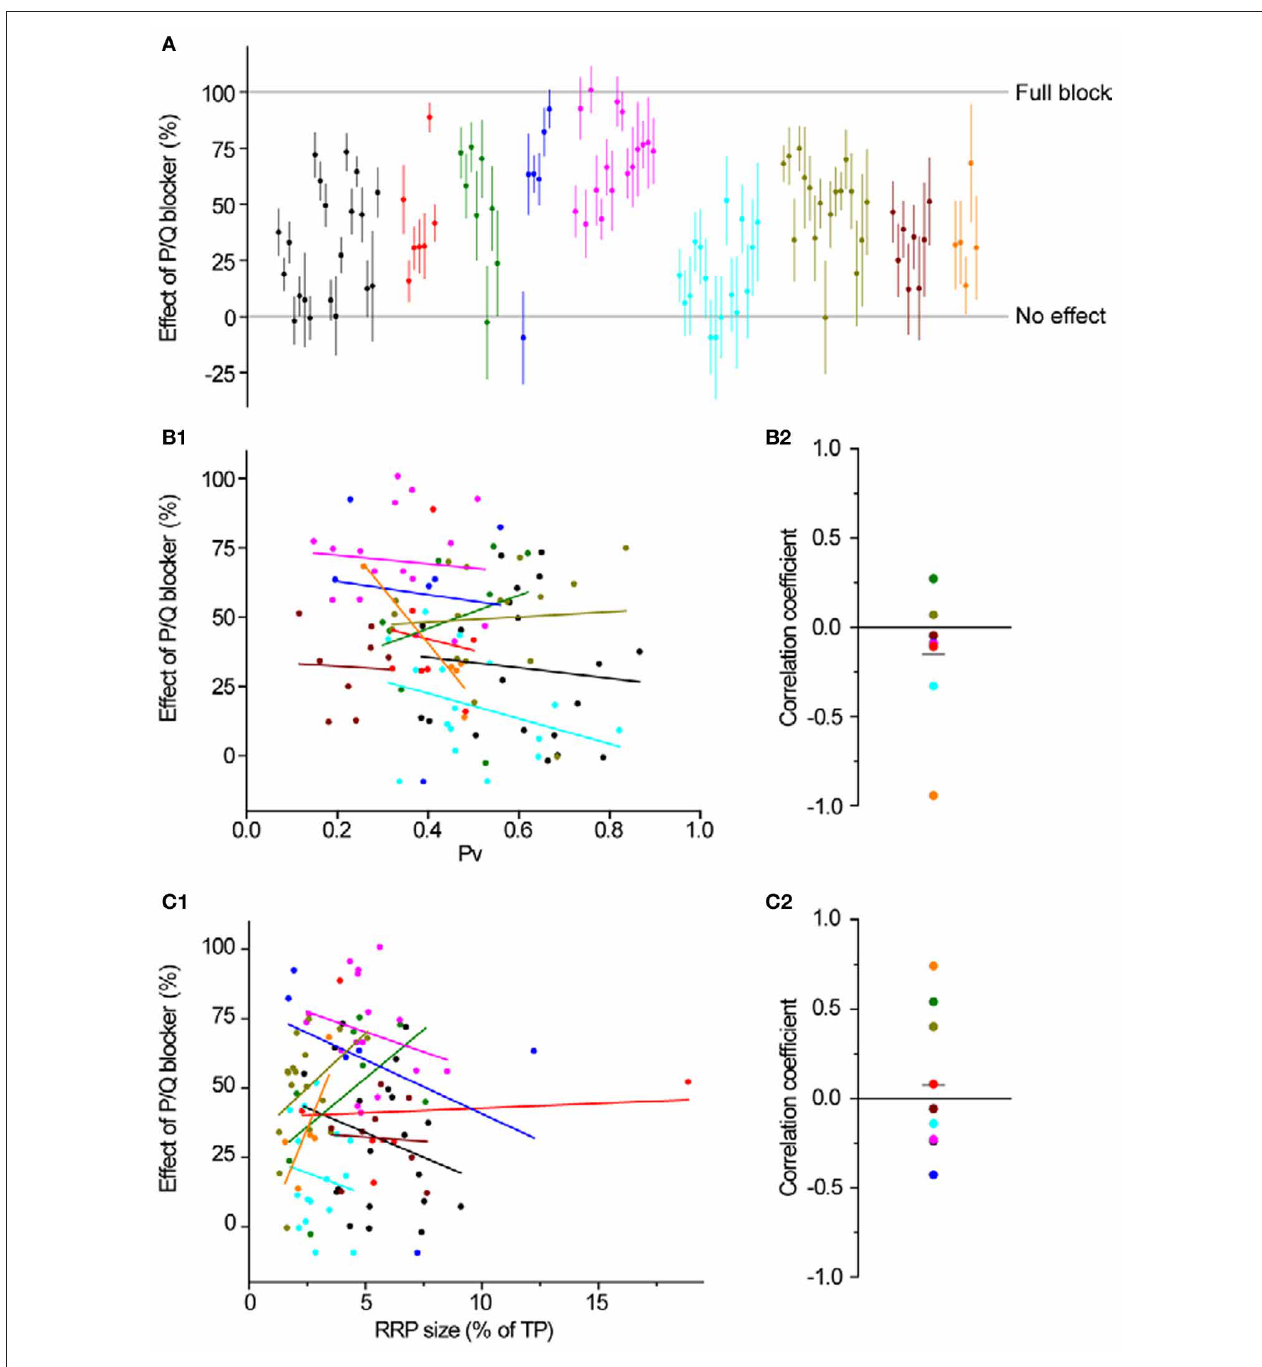
FIGURE 5 | P/Q-type Ca 2 + channel distribution is independent of Pv and RRP size. (A) The effect of ω -agatoxin IVA on exocytosis in response to a single AP. Different colors represent individual experiments, while each dot shows the effect of the blocker on a single synapse (with its SE). Experiments are ordered according to their responses to an individual AP from highest (left) to lowest (right). Within an experiment, synapses are also sorted from most (left) to least responsive (right). (B1,B2) Effect of a P/Q blocker is independent of Pv . (B1) Each dot is a synapse and the coloring scheme is the same as in (A) . Lines represent best fits for each experiment, colored accordingly. (B2) Correlation coefficients of the effect